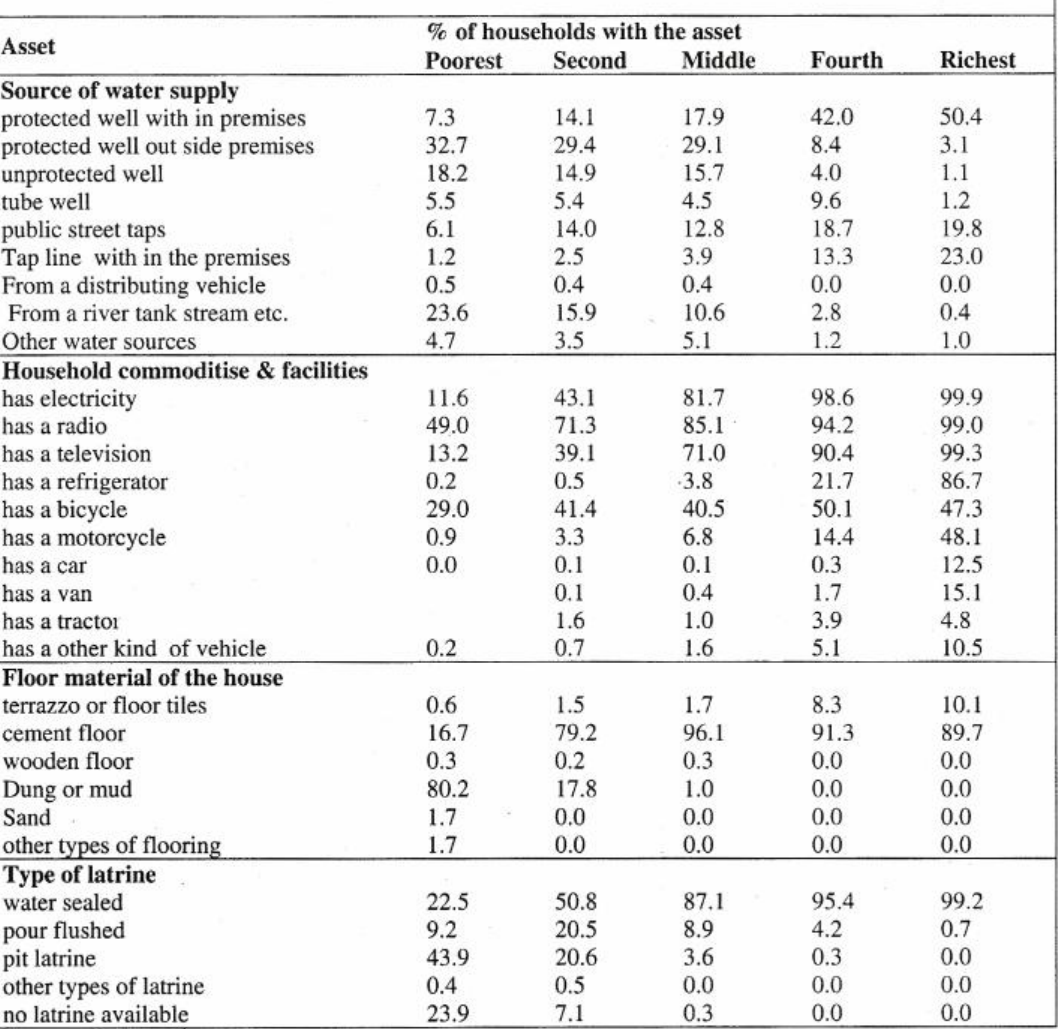
Table 4 Comparisonofaverage asset ownership across socio